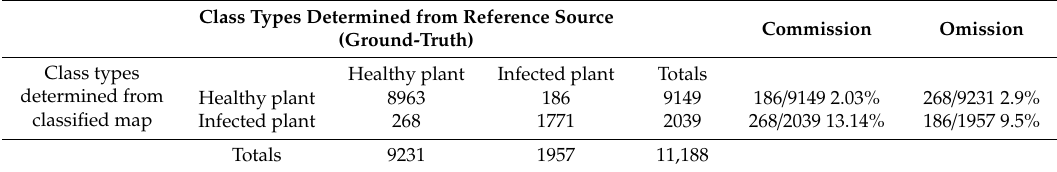
Figure 10. The imagery results getting from each step of unsupervised PBP classification algorithm. each image indicated: ( a ) CIR raw image, ( b ) the location of planting row, ( c ) the position of each individual plant, ( d ) the result of Superpixel segmentation, ( e ) the regional distribution of CRR-infested areas, and ( f ) the final result of PBP classification. In ( b ), planting rows are shown in light grey, and bare soil is shown in black. In ( e ), healthy regions are shown in green, and CRR-infested regions are shown in red. In ( f ), each yellow dot represents a healthy cotton plant, and each blue dot represents and a CRR-infected plant. Table 2. Confusion matrix of PBP classification for Region